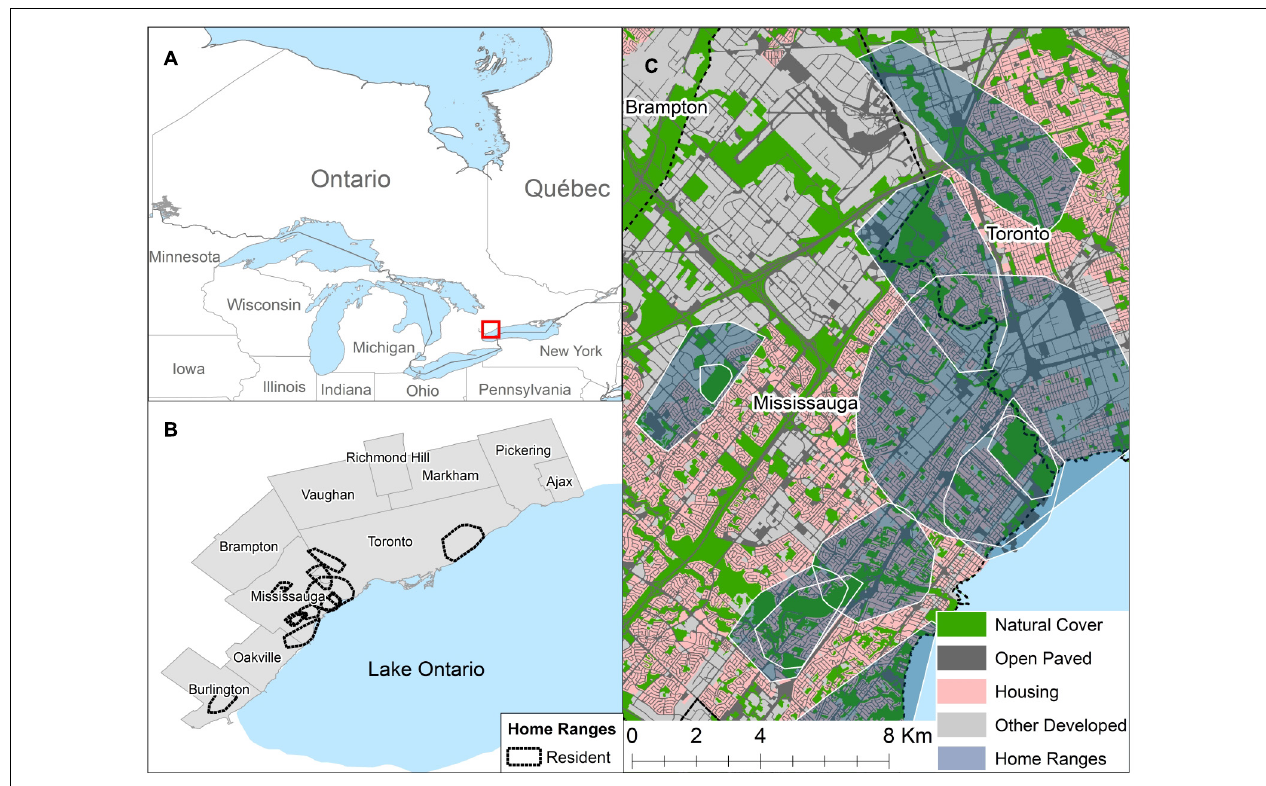
FIGURE 1 | (A) Map of Ontario with a red square showing the location of the study area. (B) Showing the boundaries of 10 municipalities that make up the contiguous urban and suburban core within the Greater Toronto Area, Canada and the location of resident coyote home ranges calculated using 95% minimum convex polygons. (C) A representative example of the distribution of different habitat classes within resident coyote home ranges in the City of Mississauga. Maps were created using ArcGIS 10.3.1. Contains information licensed under the Open Government Licence —